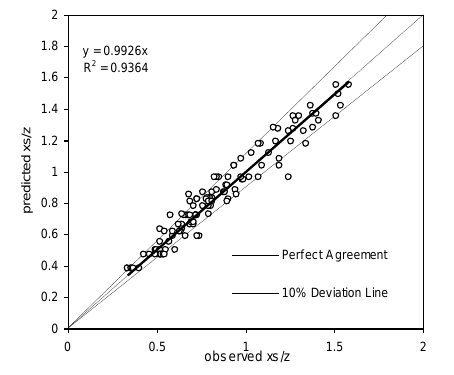
Figure 25. Comparison between observed and predicted equation (18) to estimate XS/z . y = 0.991x R 2 = 0.9777